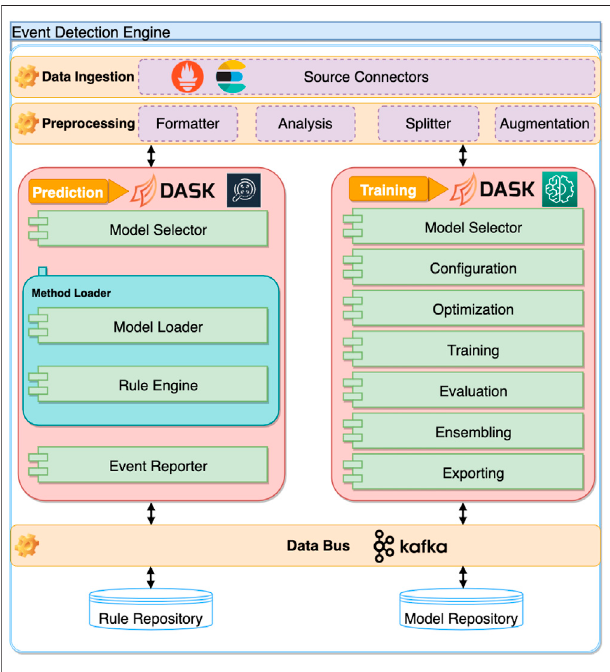
FIGURE 3 | The architectural model of the ASPIDE event detection